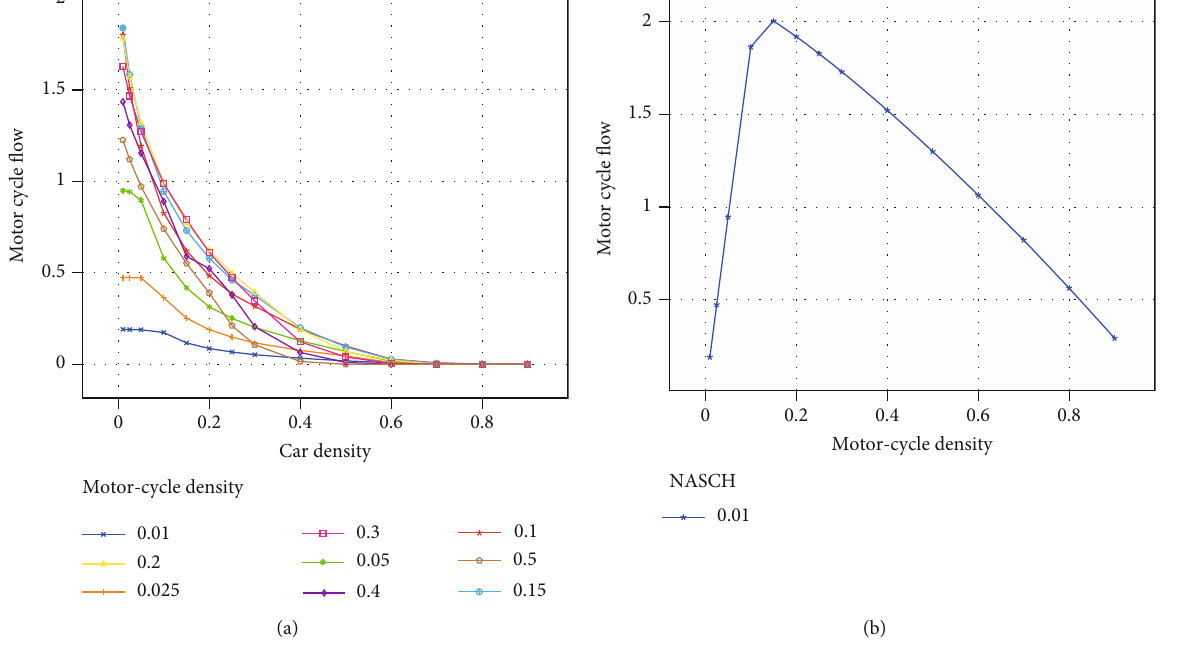
Figure 3: (a) Relation between the motorcycle fl ow and the car density with sp = 0 : 25 and Ip = 0 : 25 for di ff erent motorcycle densities. (b) Flow density relation of Na-Sch model for